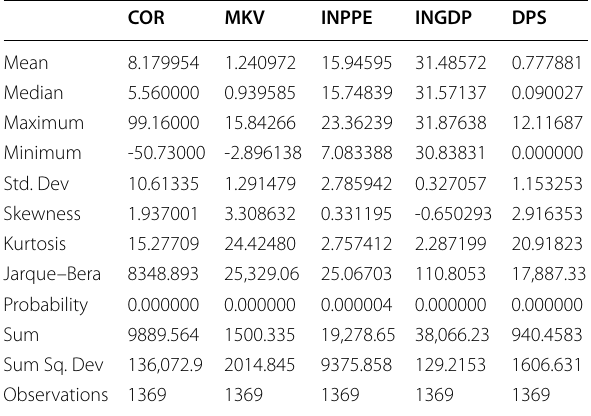
Table 1 Descriptive statistics. Source : Author’s Computation,